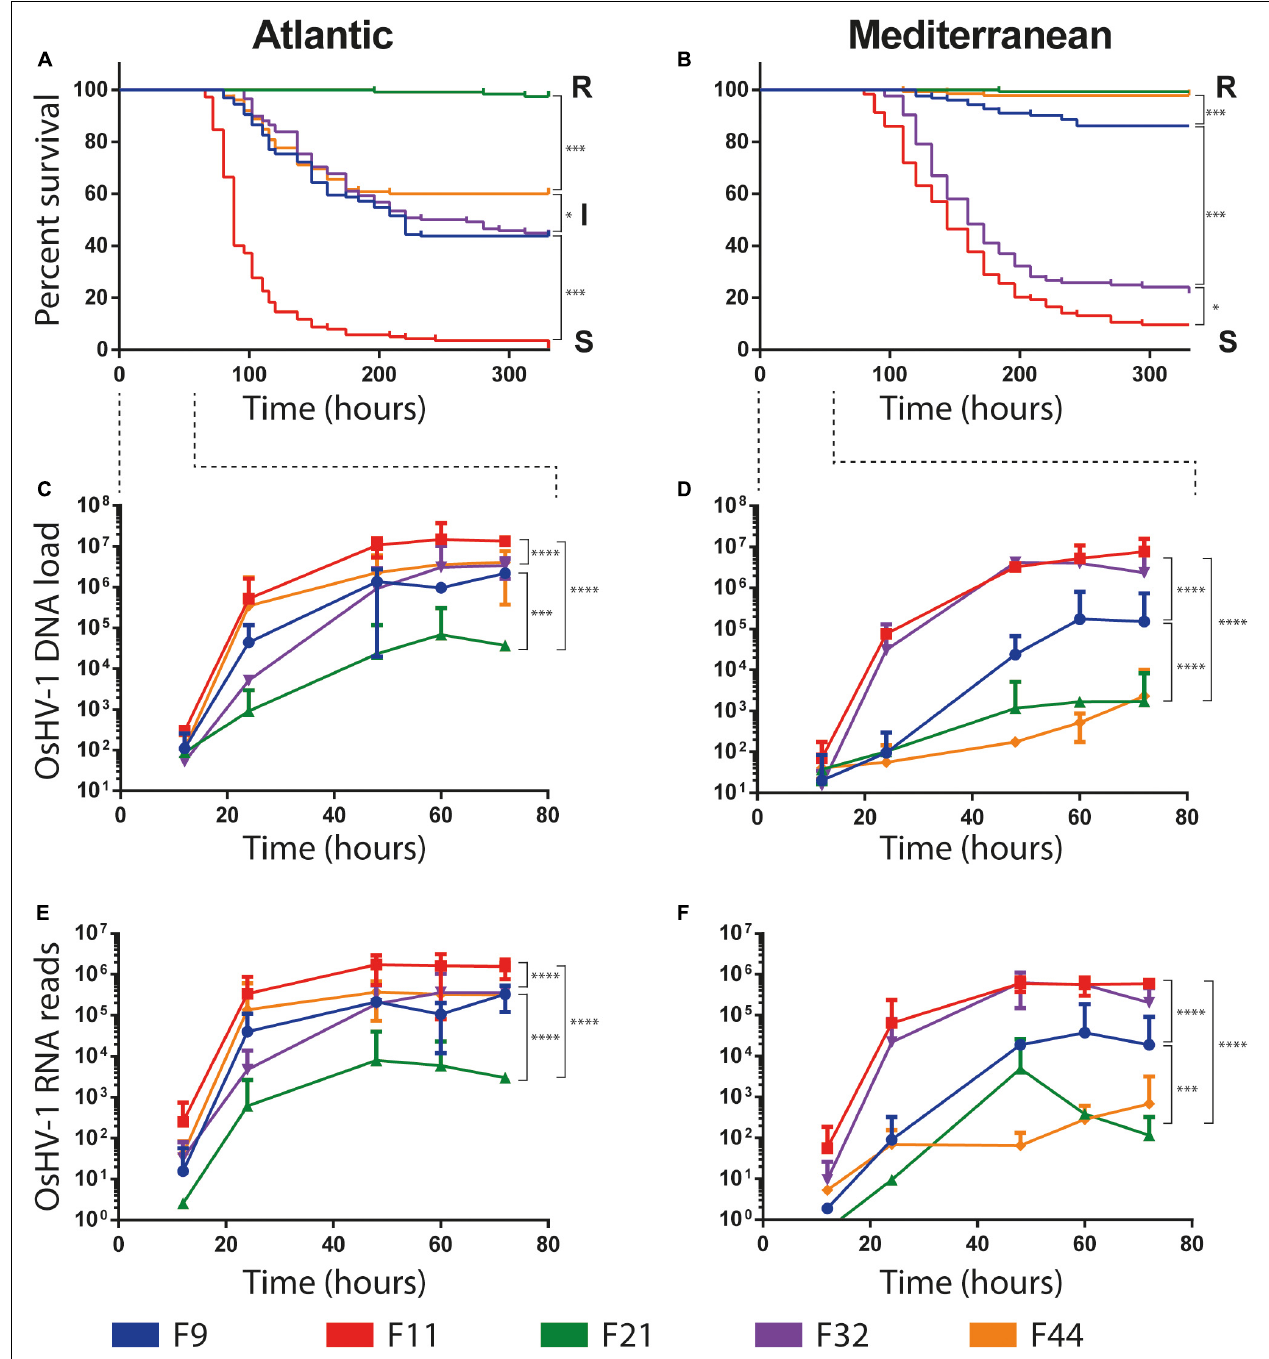
FIGURE 2 | Survival curves and OsHV-1 colonization of five biparental oyster families submitted to experimental infections using donors oysters deployed in Atlantic and Mediterranean farming area during infectious period. (A,B) Represent Kaplan-Meier survival curves of the 5 families of recipient oysters during the Atlantic and Mediterranean natural experimental infection, respectively. Resistant, intermediate and susceptible oyster families are indicated by R, I and S, respectively. The stars indicate P -values according to Mantel-Cox Log-rank test ( ∗ P ≤ 0.05, ∗∗∗ P ≤ 0.001). OsHV-1 colonization was assessed at the early time point of experimental infection at 12/24/48/60/72 h. (C,D) OsHV-1 load was quantified by qPCR and expressed as viral gene copy number per ng of oyster DNA. (E,F) Viral replication was estimated by the total number of RNA-Seq reads mapped on the OsHV-1 µ Var A genome (KY242785). The stars indicate P -value according to Mann-Whitney multiple comparisons U -tests of viral load (C,D) and viral replication rate (E,F) between families at late phase of infection (48/60/72 h) ( ∗∗∗ P ≤ 0.001 ∗∗∗∗ P ≤ 0.0001).